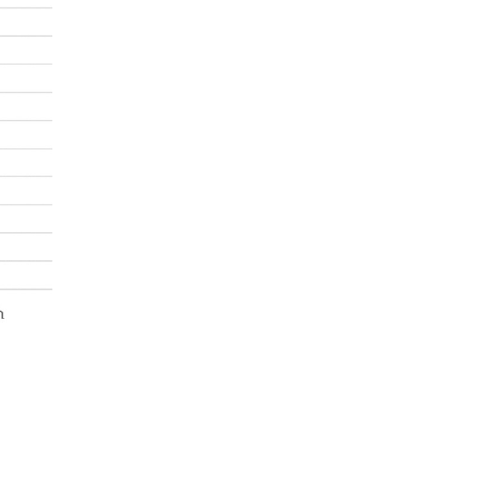
Fig 5. The moderating role of participation in decision-making in the relationship between the perceived risk of being infected at work and emotional exhaustion. Perceived risk = perceived risk of being infected at work. Participation = participation in decision making. SD = standard